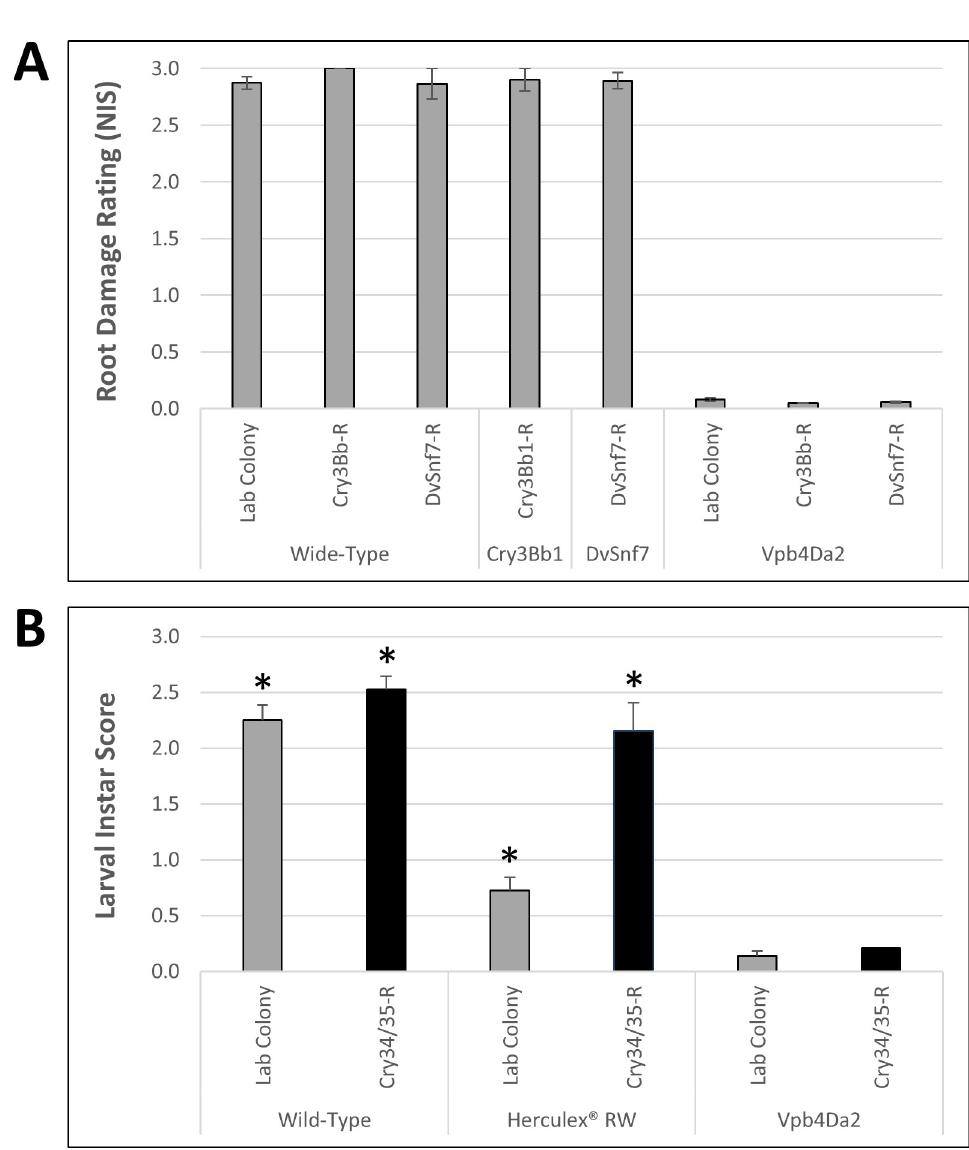
Fig 3. WCR colonies resistant to Cry3Bb1, DvSnf7 RNA, or Cry34Ab1/Cry35Ab1 are not cross-resistant to Vpb4Da2. ( A ) Cry3Bb1- or DvSnf7 RNA-resistant WCR colonies are not cross-resistant to Vpb4Da2. Mean ( ± SEM) of NIS scores in growth chamber whole-plant root protection assays are shown, in which 2,000 eggs from a susceptible lab colony (Waterman), Cry3Bb1-resistant colony, or DvSnf7 RNA-resistant colony were infested on individual maize plants from wide-type or transgenic lines expressing Vpb4Da2 (Vpb4Da2-2), Cry3Bb1, and DvSnf7 RNA, respectively. ( B ) Cry34Ab1/Cry35Ab1-resistant WCR colony is not cross-resistant to Vpb4Da2. Mean ( ± SEM) LIS scores are shown for susceptible (Crop Characteristics) or Cry34Ab1/Cry35Ab1-resistant WCR larvae recovered after 10 days on individual maize plants from wild-type or Herculex 1 RW expressing Cry34Ab1/Cry35Ab1. � LIS scores for two WCR colonies are significantly different on a same maize line at p = 0.05, error bars indicate